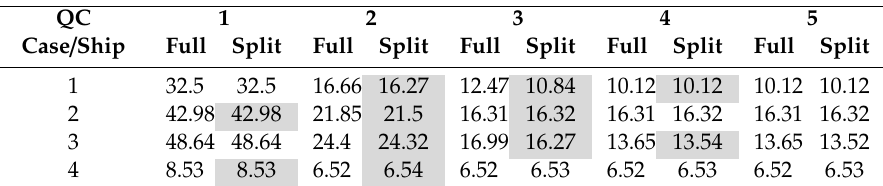
Table 3. Example of scenarios